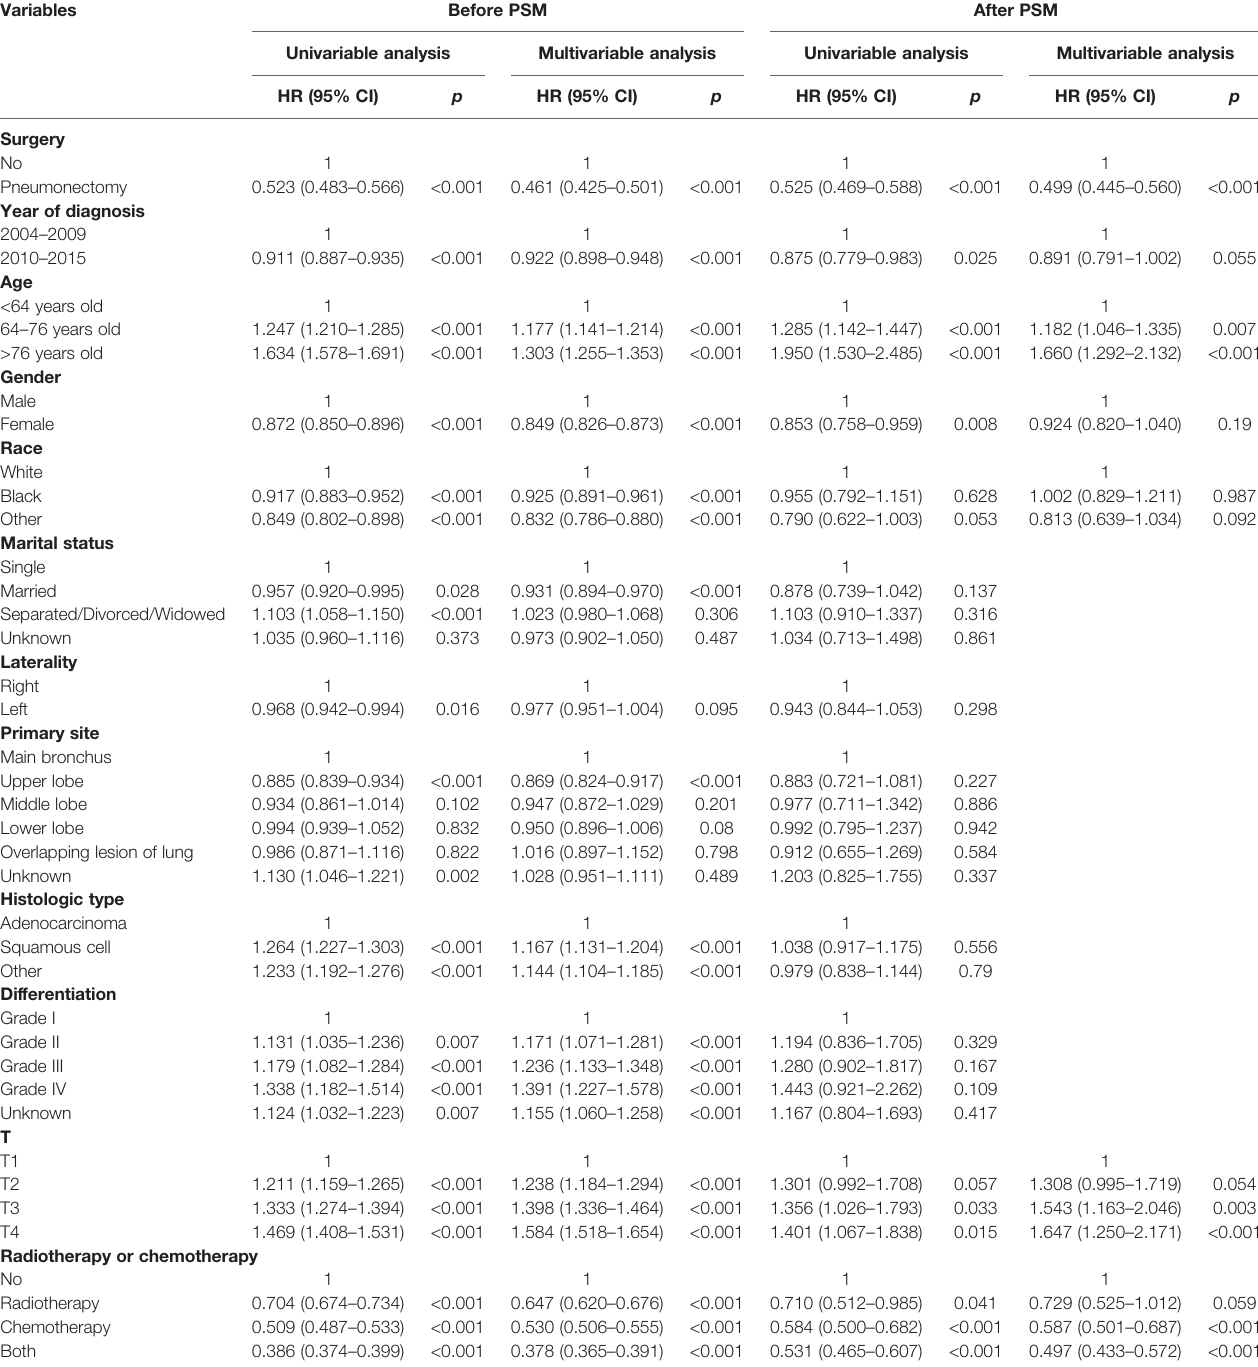
TABLE 2 | Cox regression analysis of the in fl uence of pneumonectomy on OS in stage T1 – 4N2M0 NSCLC patients. Variables Before